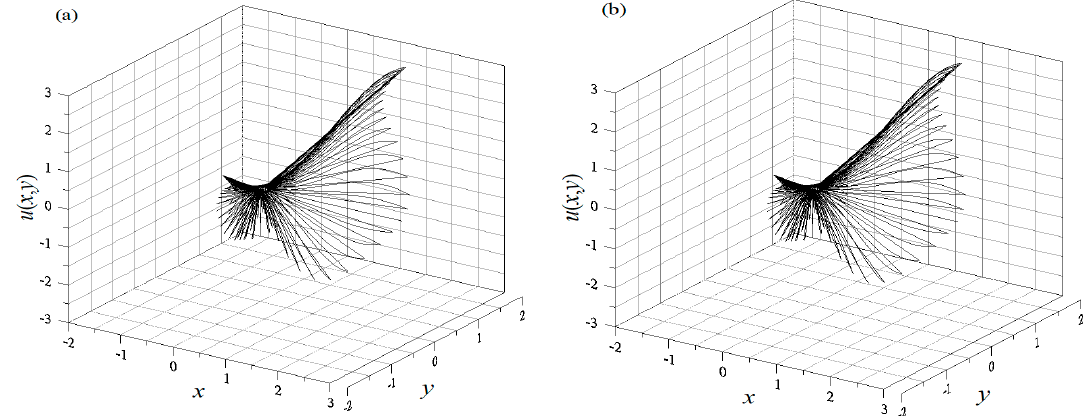
Figure 18. The exact solutions for the steady-state AC equation with amoeba-like irregular domain are shown in ( a ), and in ( b ) the proposed scheme solution without random noise.